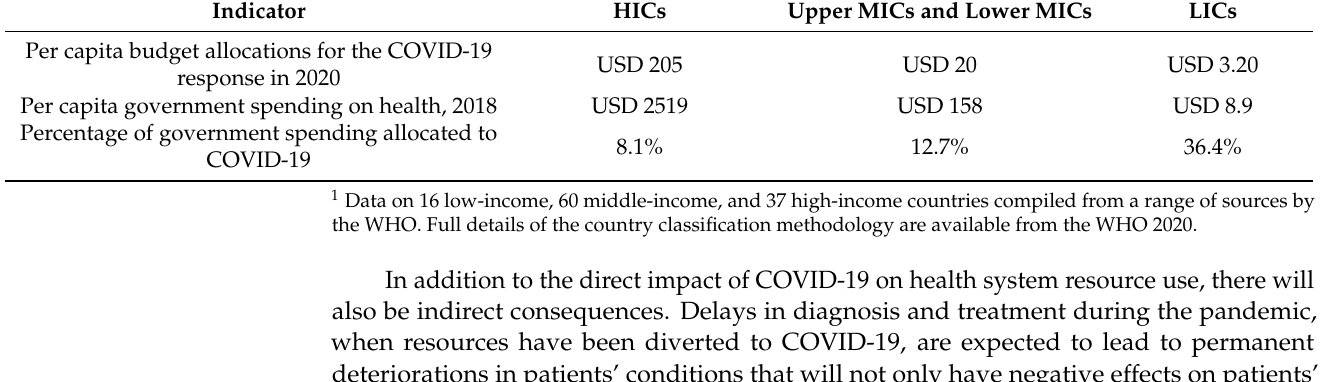
Table 3. Spending on COVID ‐ 19 as a proportion of health system budgets [14] 1.